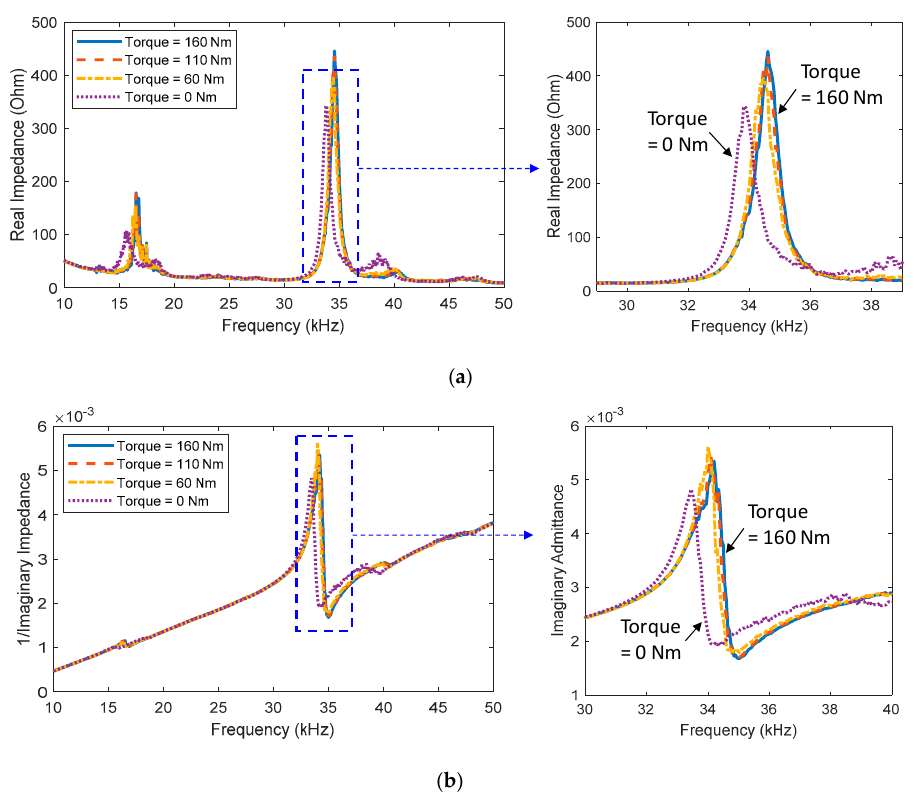
Figure 4. Measured impedance signatures under three cases of sensor breakage: ( a ) real part; ( b ) imaginary part.